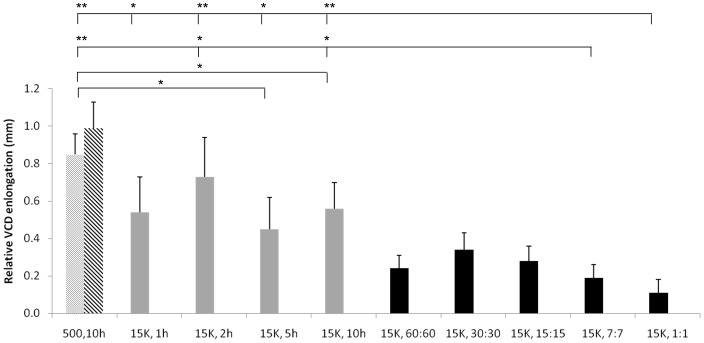
Relative increase in vitreous chamber depth (VCD) in eyes with monocular diffusers (bars grey-scale coded as in Figure 1).Although there was no significant difference among treatment groups for either paradigm (Paradigm I: F = 1.639, P = 0.204 and Paradigm II: F = 2.075, P = 0.109), the increase of VCD in chickens reared under constant bright light for 5 or 10 hours was signifcantly supressed compared with those under standard illuminance (P = 0.029 and 0.037, respectively). In comparison with constant bright light, this effect was further enhanced in chickens exposed to cycles of bright light at a frequency of 7∶7 or 1∶1 minutes (all P<0.05, except for the comparison between the 7∶7 minute cycle and the 5 h constant bright light exposure, P = 0.180 and a borderline significance between the 7∶7 minute cycle and the 1 h constant bright light exposure, P = 0.075).* <0.05, **<0.01. Abbreviations as in Figure 1.